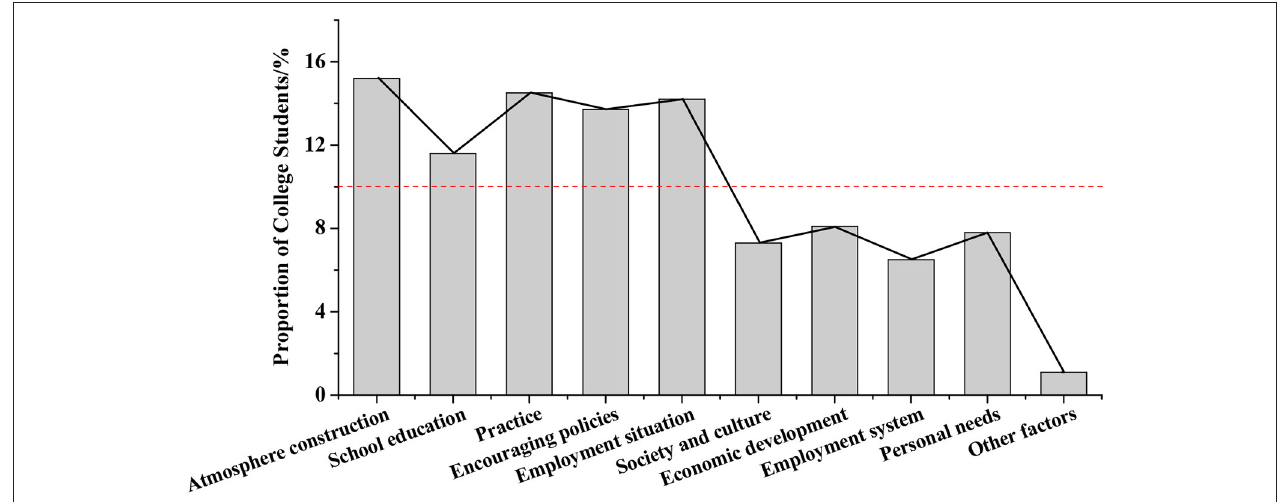
FIGURE 5 | Analysis of entrepreneurial value’s restricting